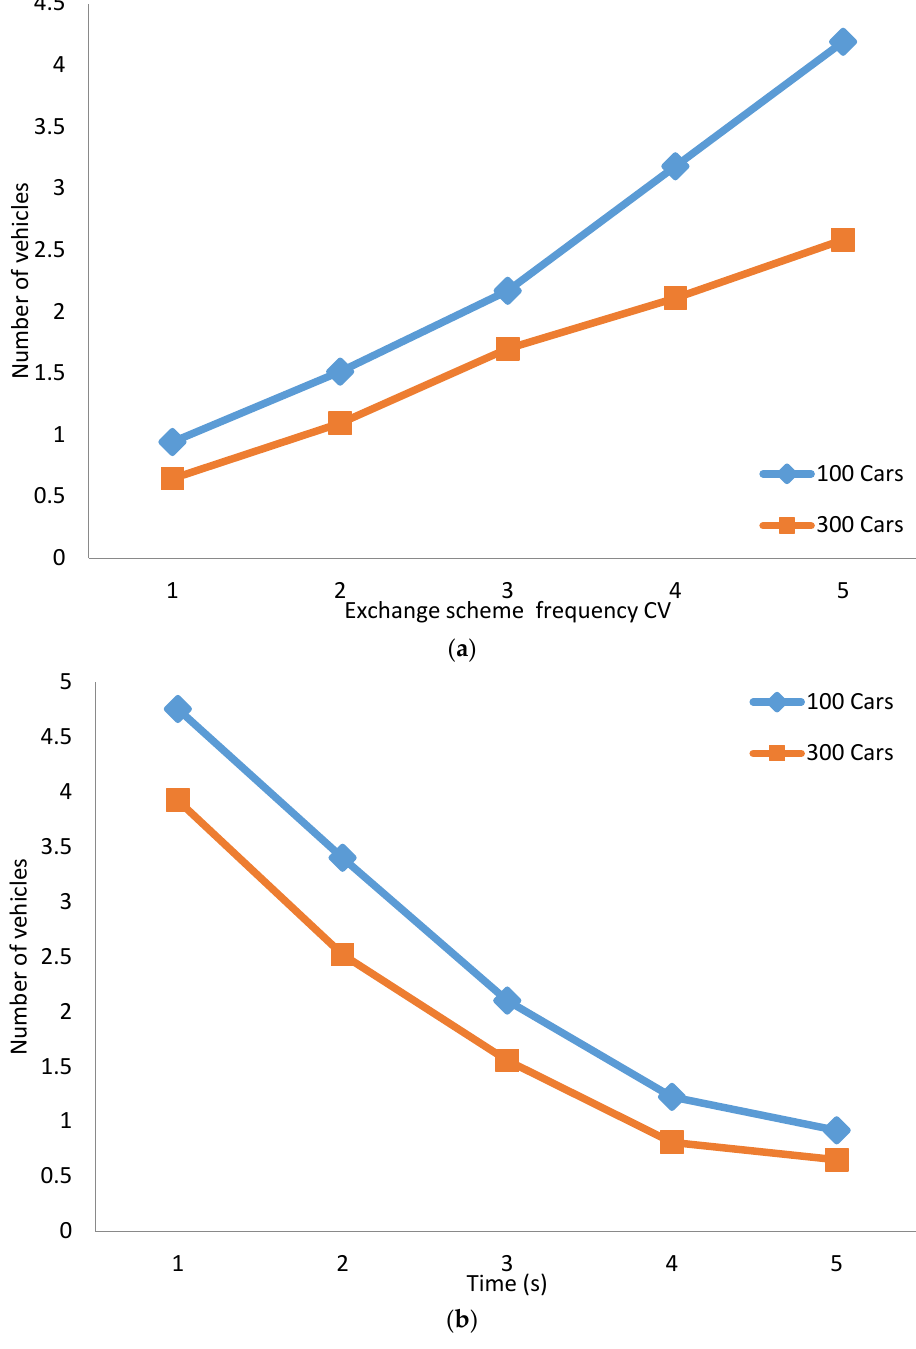
Figure 15. Deviations of the number of vehicles: ( a ) in different exchange frequencies; and ( b ) at different instances of time.